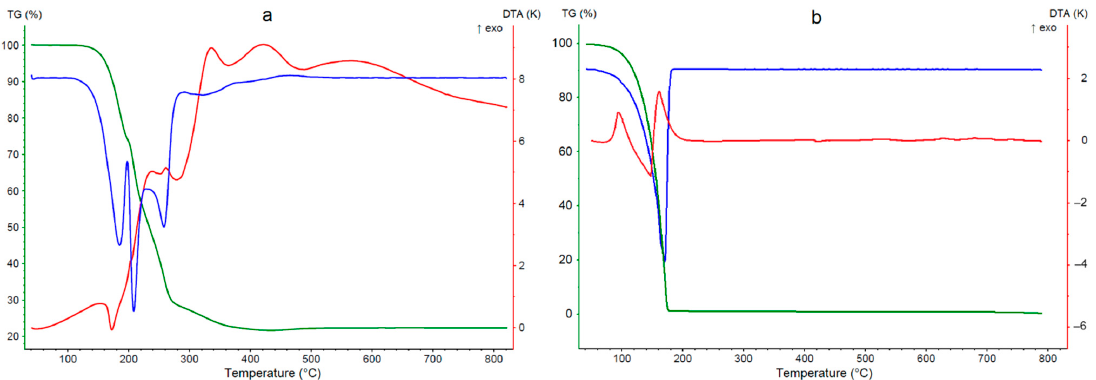
Figure 6. TG (green), DTG (blue), and DTA (red) curves for [Cu 2 (tig) 4 (tigH) 2 ] ( a ) and tyglic acid ( b ).